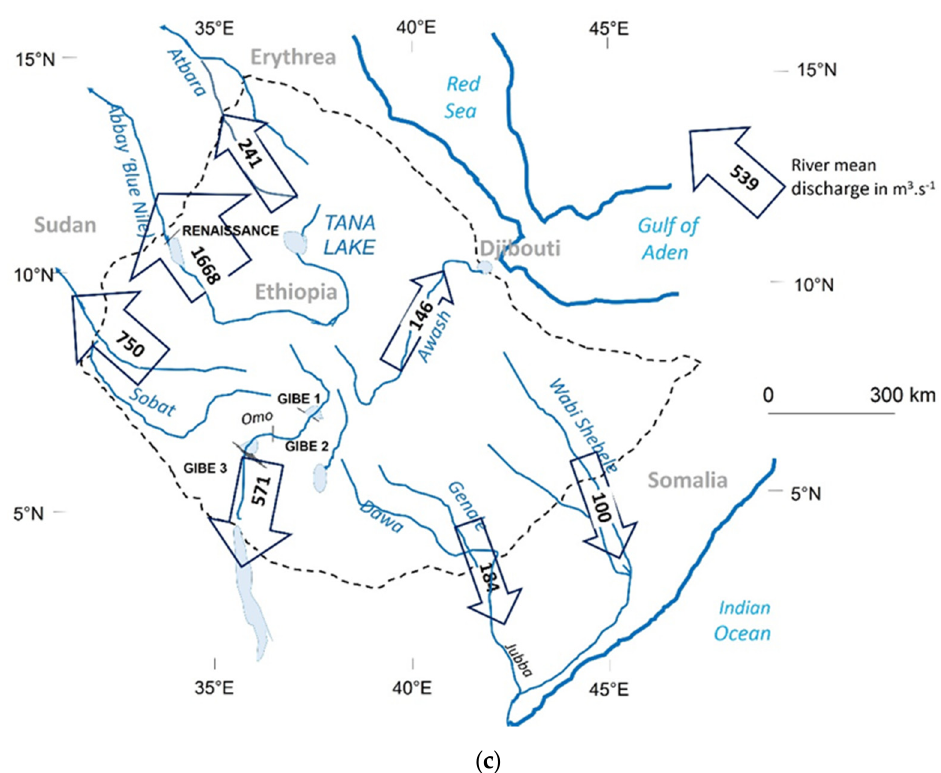
Figure 1. The two main natural water towers of northern sub-Saharan Africa and their 1951–2000 mean annual discharges; ( a ) comparison of the water towers (total discharges of French rivers is given for comparison purposes); ( b ) the Guinean water tower; ( c ) the Ethiopian water tower.